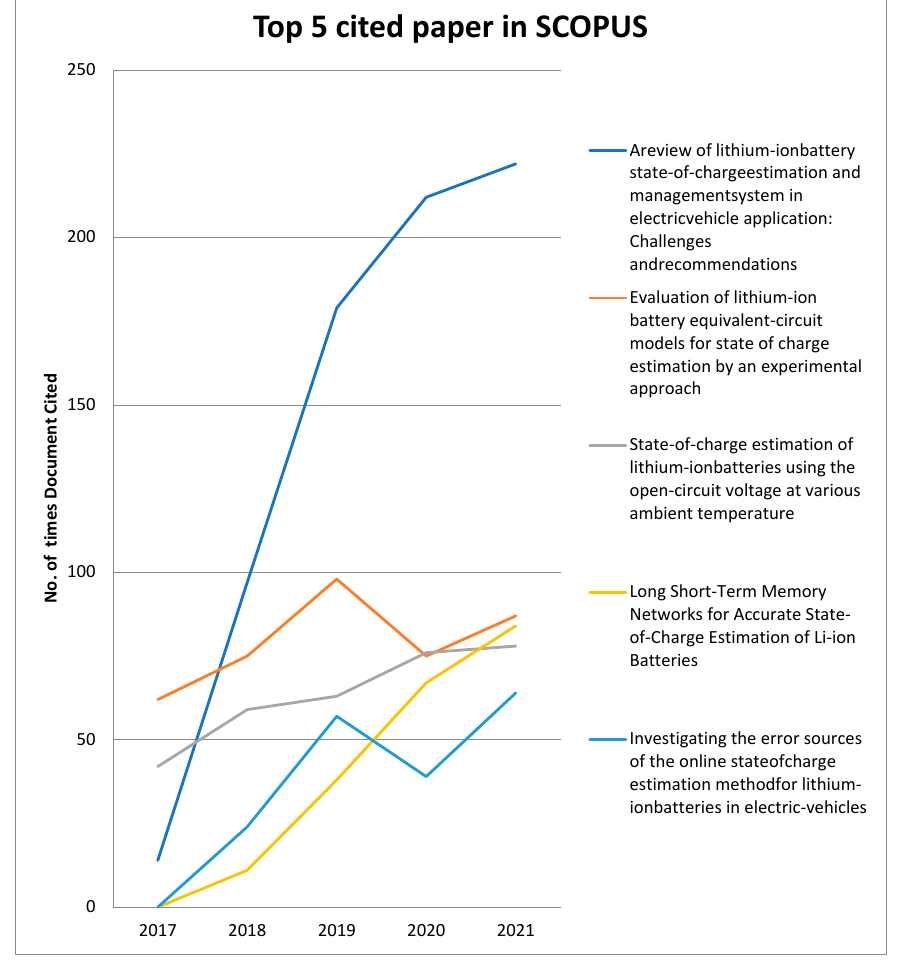
Top 5 cited paper in SCOPUS